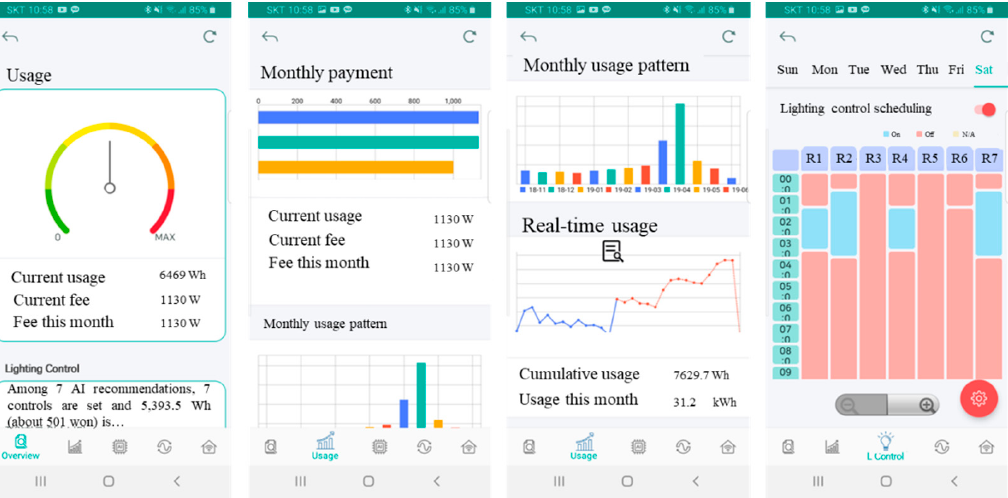
Figure 8. HCL Platform Use Case.